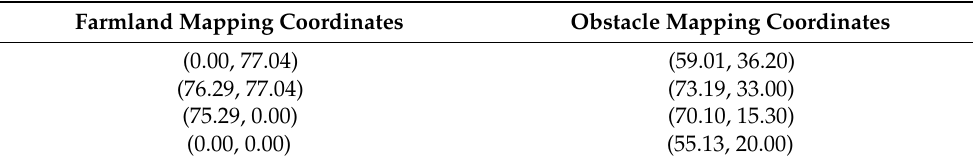
Table 4. Coordinate mapping to Figure 9b.